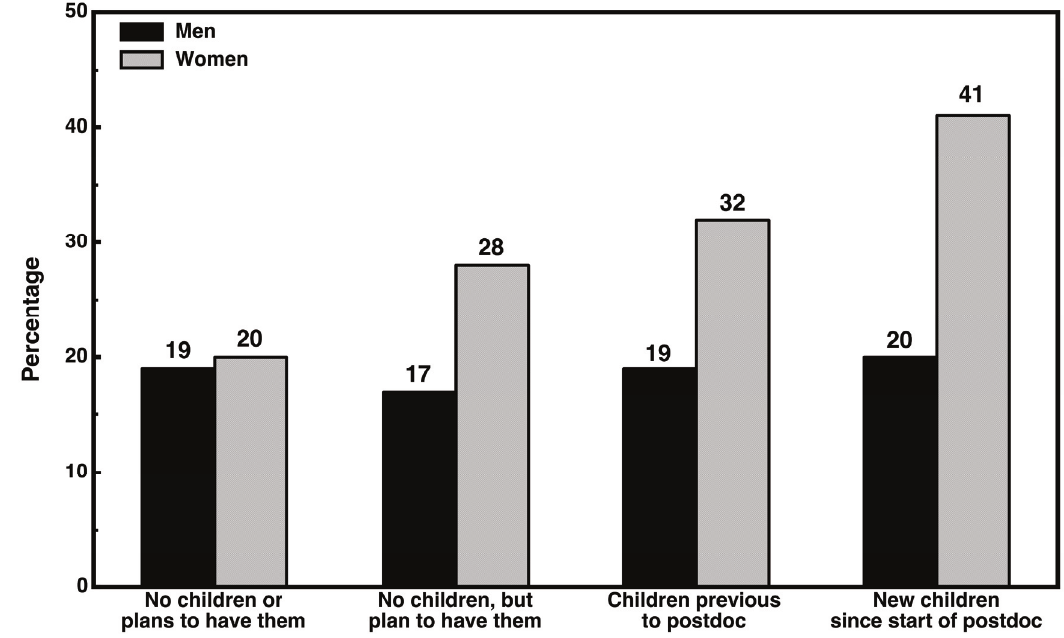
Figure 4. Percentage of postdoctoral researchers who decided against academic research careers, sorted by gender. Results from a 2009 survey of postdoctoral fellows at the University of California, based on data presented in ref.